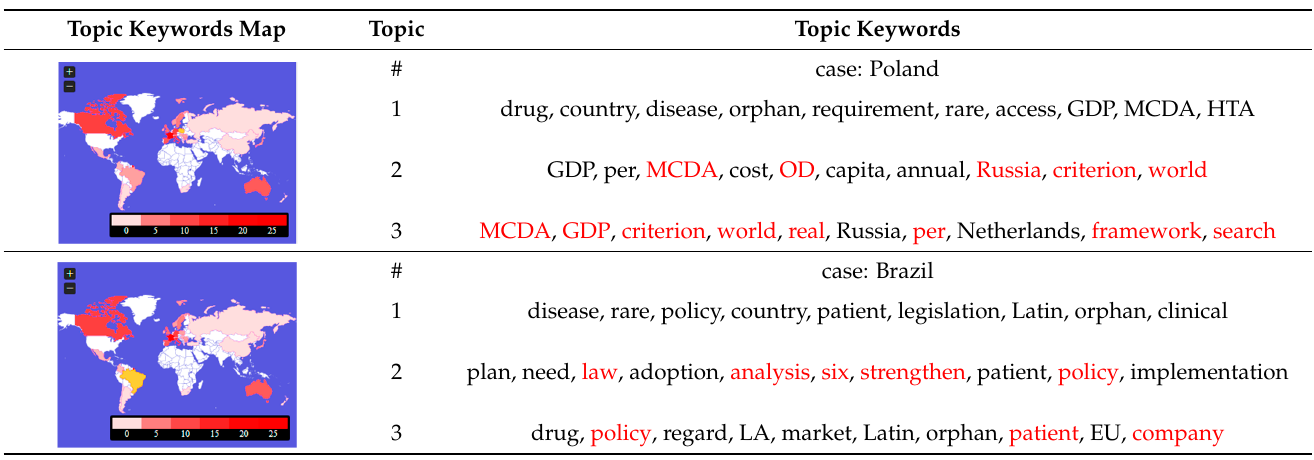
Table 2. Topic modeling using latent semantic indexing (LSI) for countries.